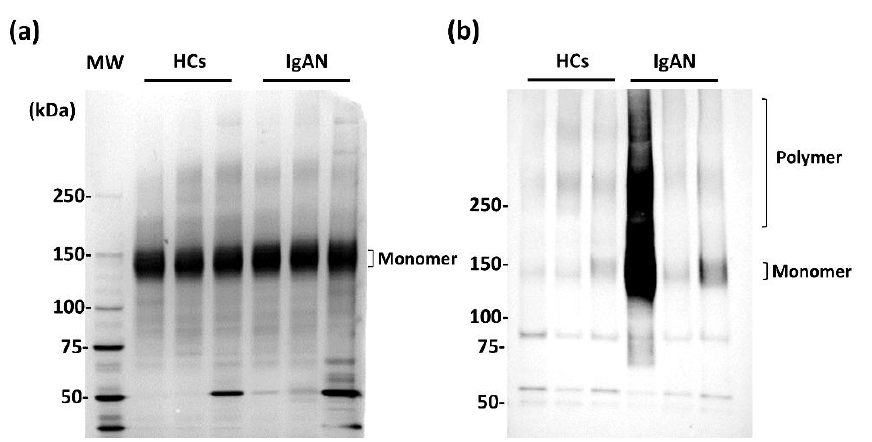
Figure 1. Verification of WFA binding to serum-agglutinated IgA1. ( a ) Silver stain of immunoprecipitated fraction with anti-IgA1 mAb. ( b ) Western blot analysis of WFA-immunoprecipitated fraction detected with anti-IgA1 mAb. MW; molecular weight, HCs; healthy control subjects.